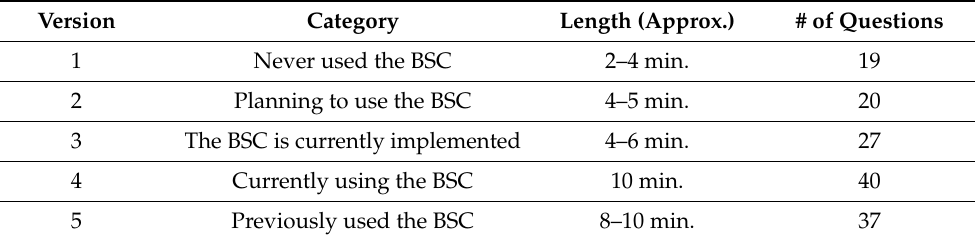
Table 1. Di ff erent versions of the